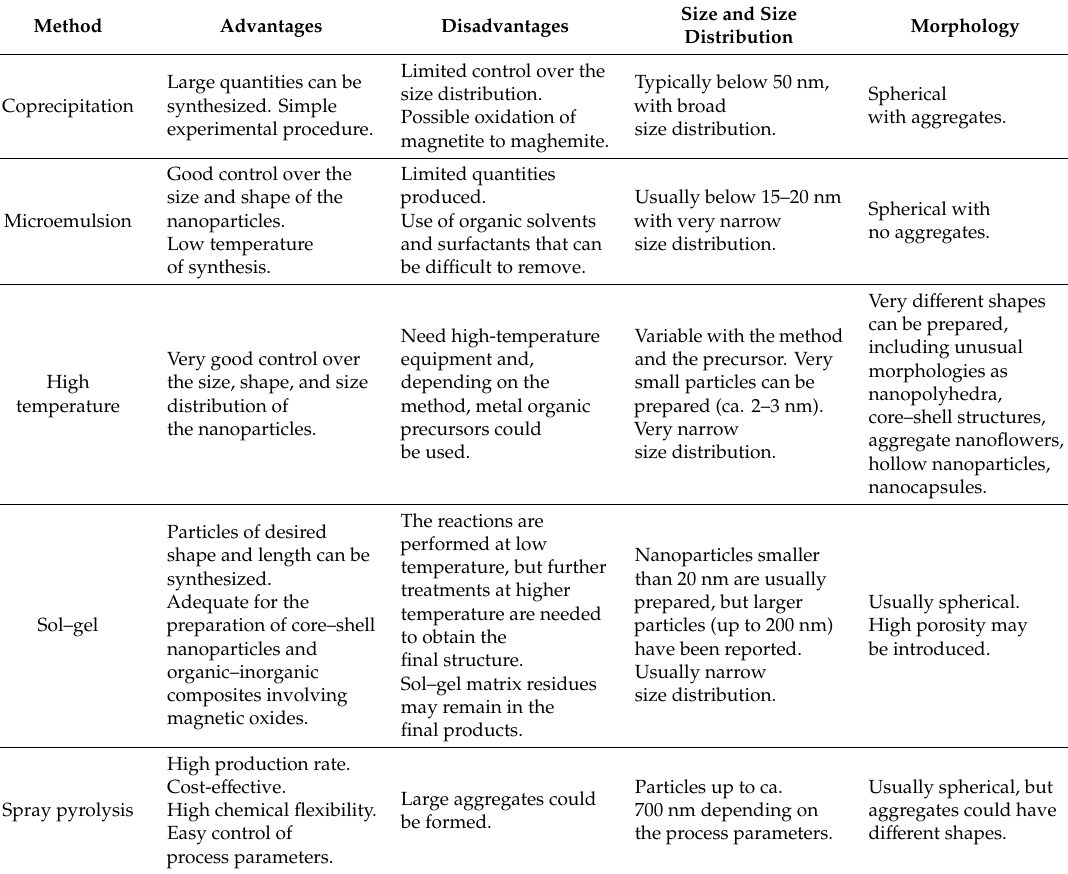
Table 1. Comparison of representative synthesis